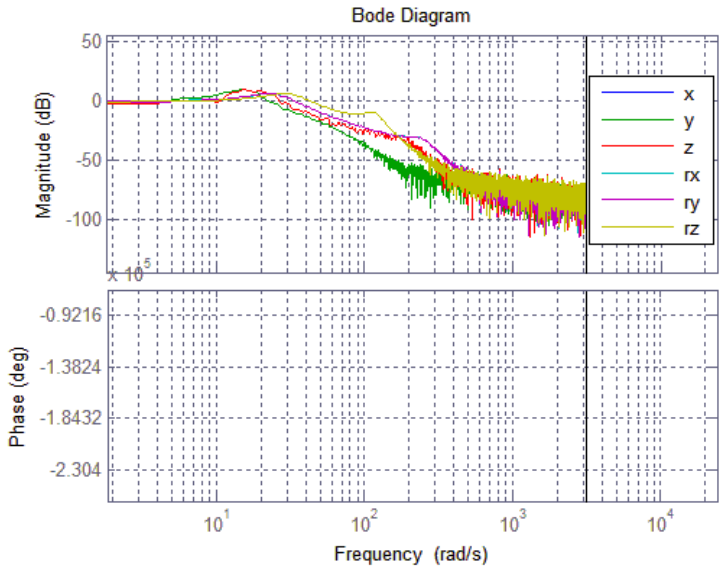
Figure 9. The closed-loop Bode diagram of the direct drive Stewart manipulator with PD plus dynamic pressure feedback